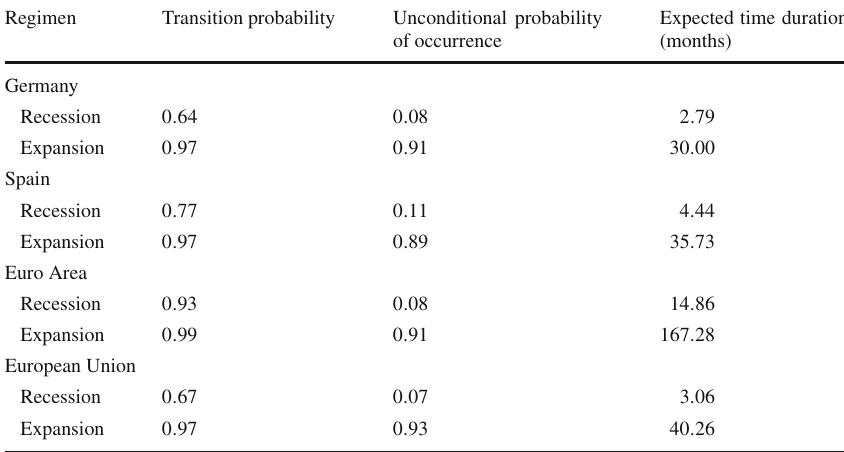
Table 6 Characteristics of business cycle phases. Source: author’s calculations Regimen Transition probability Unconditional probability of